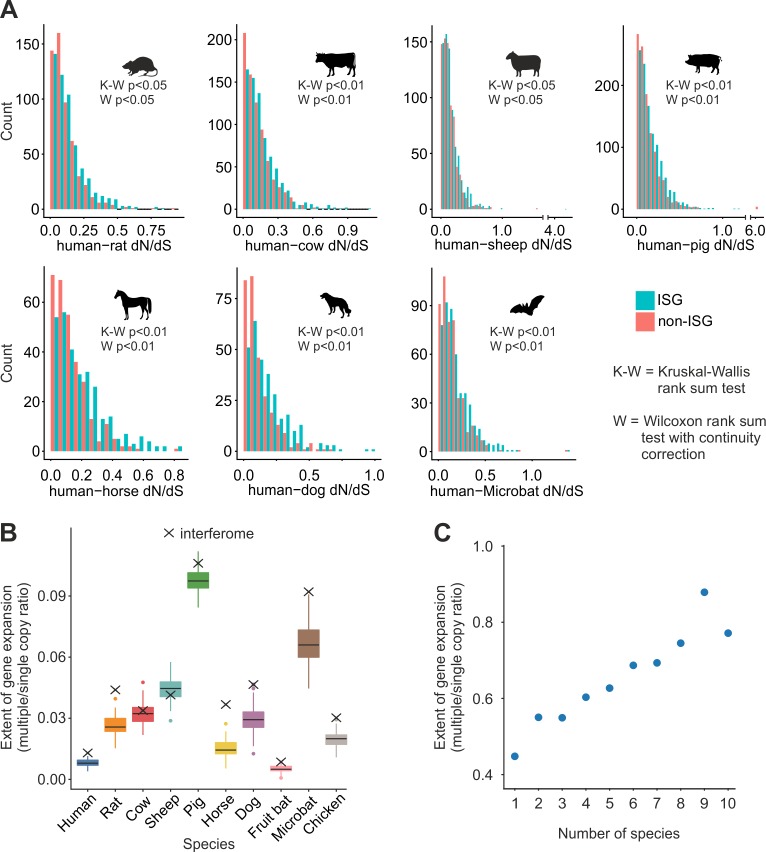
Evolutionary properties of ISGs.(A) For each nonhuman species, ISGs with one-to-one orthologs that were up-regulated in the human interferome and an identical number of random genes not differentially expressed by IFN stimulation were selected. dN and dS values were then retrieved from the Ensembl database. Histograms show dN/dS ratio values for ISGs (blue) and non-ISGs (red). Differences in the distribution of dN/dS values of the non-ISGs compared to ISGs were tested using the Kruskal–Wallis rank sum test and Wilcoxon rank sum test with continuity correction. (B) The extent of gene expansion was compared between ISGs and the genome as a whole. The y-axis represents the ratio between the number of genes for which there are paralogs (multiple) and those which are orthologs (single) as a proxy for gene expansion. Boxes and whiskers represent the values for 500 randomly selected non-ISGs, while ‘×’ represents the mean value for the ISGs for each species. With the exception of the sheep, all ISG values were above the median value. The code used for the random sampling and the generation of Fig 4A and 4B is provided in S3 Data and S4 Data, respectively, with the input file available as S5 Data. (C) Up- or down-regulated genes were divided into bins according to the number of species in which they were differentially expressed. The extent of gene expansion was calculated as panel B (S1 Data). A positive trend was identified for up-regulated genes whereby the greater the number of species which up-regulate a gene, the greater the likelihood of copies being retained (P < 0.05). IFN, interferon; ISGs, interferon-stimulated genes; K-W, Kruskal-Wallis; W, Wilcoxon rank sum test.